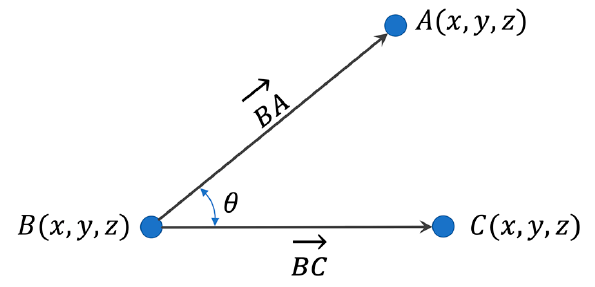
Figure 12. WMSDs risk-assessment system, which supports various computing environments. Figure 13. Calculate the angle of three joints.